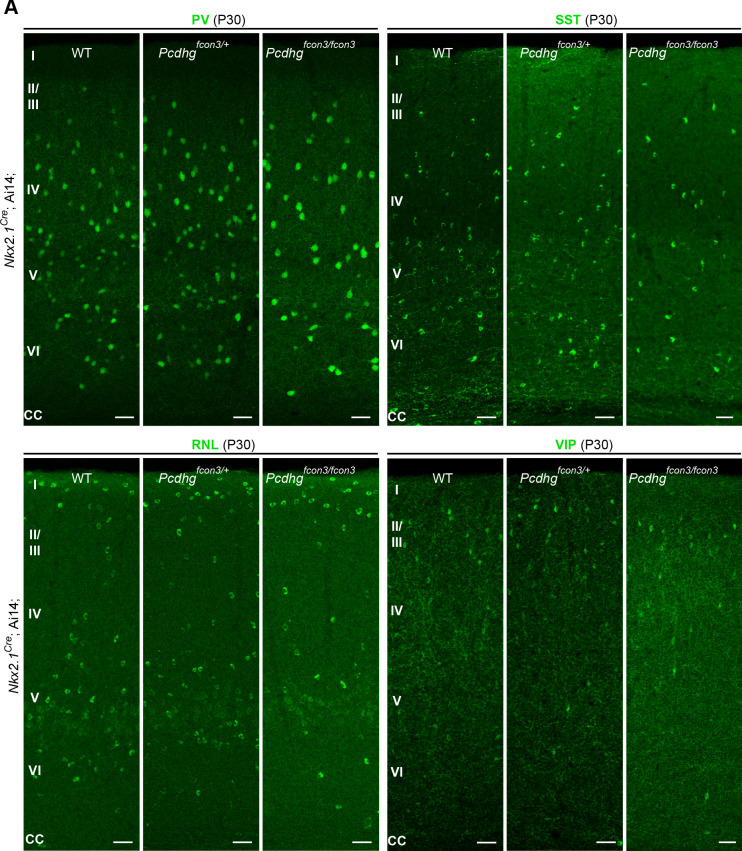
Reduced number of MGE cIN subtypes after loss of Pcdhg in Nkx2.1-derived cells.(A) Representative photographs of visual cortex (V1) in Nkx2.1Cre;Ai14;Pcdhg WT, Pcdhg heterozygote or Pcdhg mutant mice. Sections were stained for PV, SST, RLN or VIP. Scale bars, 50 μm.